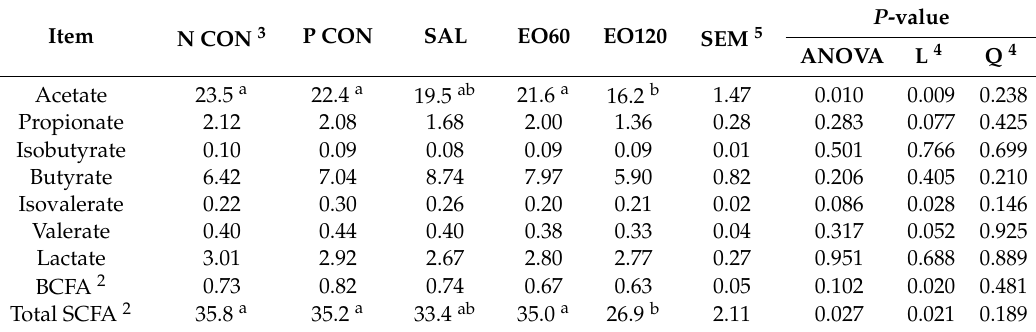
Table 5. E ff ect of dietary encapsulated essential oils on concentrations (mM / g) of cecal volatile fatty acids (VFA) in coccidiosis-vaccine-challenged broiler chickens 1.